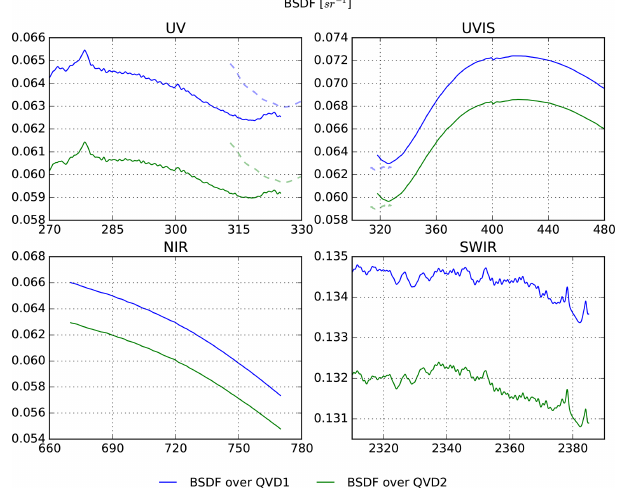
Figure 18. The instrument BSDF plotted versus wavelength for both QVDs as calculated from the ABSRAD and ABSIRR cali- bration key data, which in turn are calculated from the FEL lamp measurements. Shown is the optical axis row over the performance range. The BSDFs for QVD1 and QVD2 have the same shape but are shifted due to the different throughput. The dashed lines in the UV and UVIS panels indicate the overlap region between the two spectrometers. Note that the solid and dashed lines do not coincide, which is expected because the optical paths of the spectrometers differ. The high-frequency structures are not understood and could be caused by the stimuli